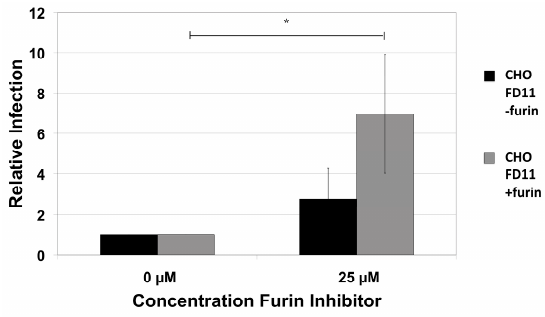
Figure 2. Infection of furin-negative CHO FD11 ( − furin) cells and furin-positive CHO FD11 (+furin) cells. Infection of furin-negative and the furin-positive CHO FD11-derivative cell lines with HPV16 in the presence or absence of 25 µM furin inhibitor. Infections were analyzed by RT-qPCR measuring the relative amount of E1^E4 transcript two days post-infection normalizing to infection by the CHO parental cells. The results are expressed as the means of at least three independent infections utilizing at least two different virus preps and standard deviations are shown. Statistical significance (denoted by asterisks) was determined by student’s t -test and significance was defined as p ≤ 0.05.